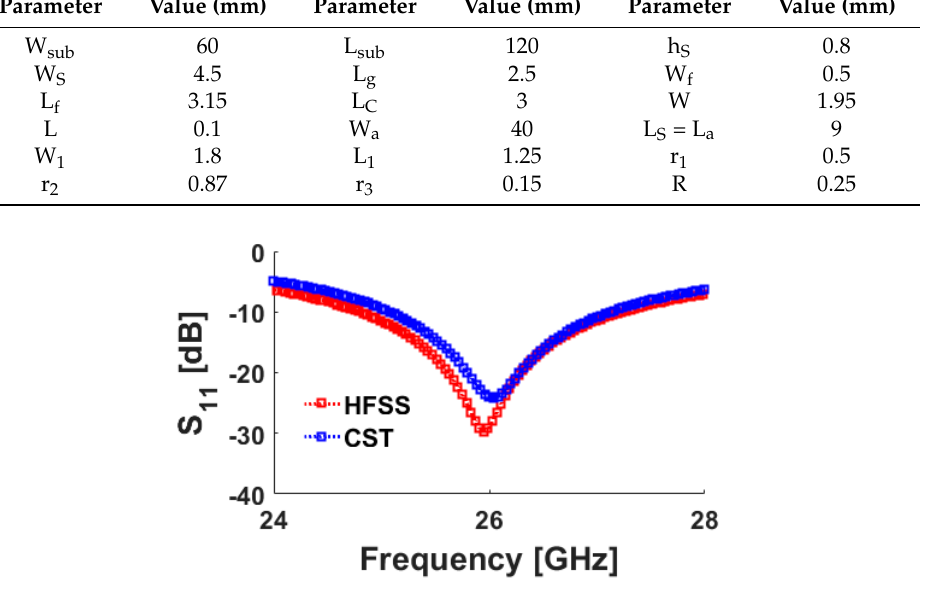
Figure 2. S 11 function of the antenna.